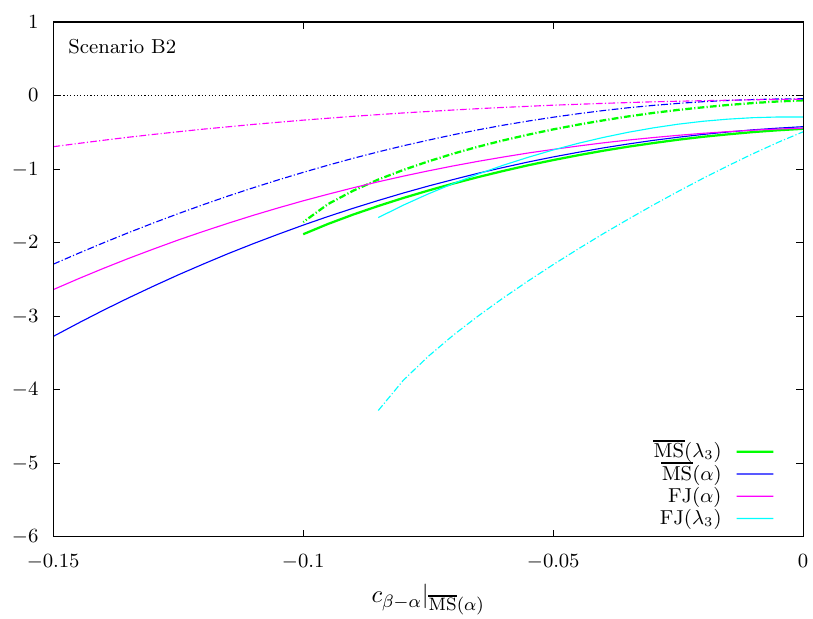
Figure 32 . The h 4 f width at LO (dashed) and NLO EW+QCD (solid) in the THDM sce- ! nario B2, normalized to the respective SM values. The input is de(cid:12)ned in the MS( (cid:11) ) scheme, and the corrections are computed in all four schemes which are displayed using the colour code of (cid:12)gure